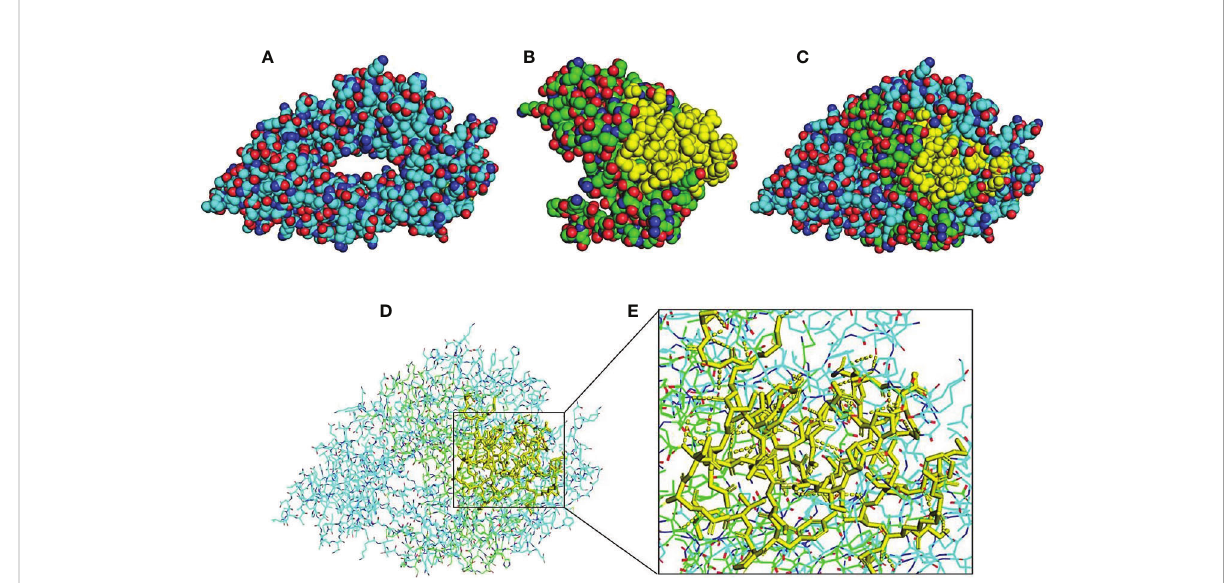
FIGURE 10 Molecular visualization and interaction 3D structure analysis and visualization by using PyMOL software integrated with Python. Models (A, B) indicate 3D structures of PD-L1 and scFv-PDL1. The yellow regions indicate the CDR regions of the scFv molecule. Model (C) indicates a merged model of both antigen and antibody fragment and (D) shows surface binding interaction. H-bonding interactions are indicated in dotted lines in (E)